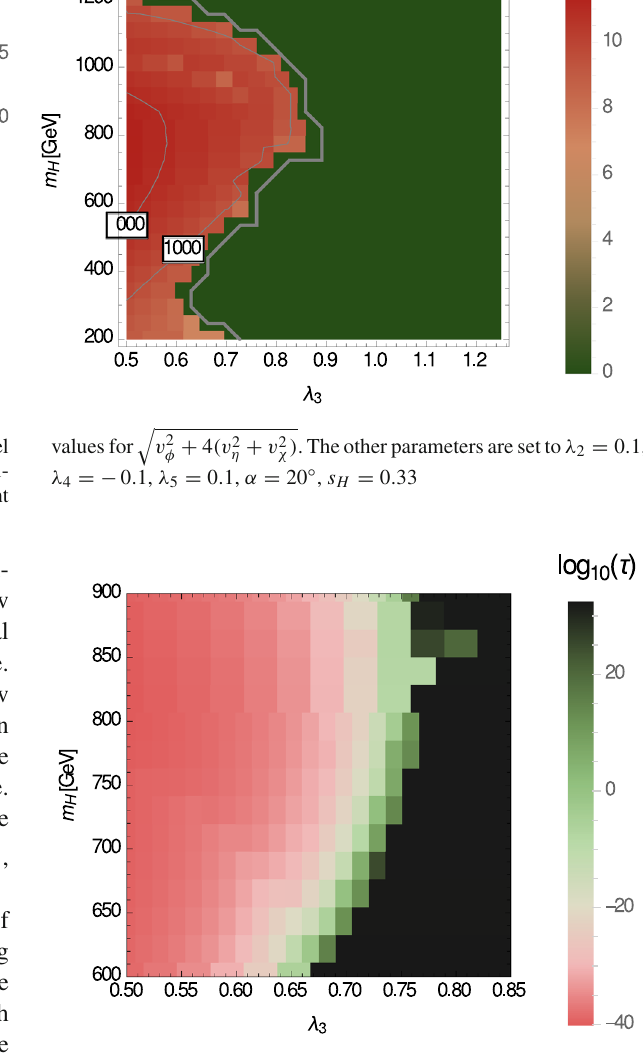
Fig. 14 Zoomintotheparameterplaneoftheright-handsideofFig.13 and presenting the calculated life-time of the electroweak vacuum nor- malised to the life-time of the universe at zero